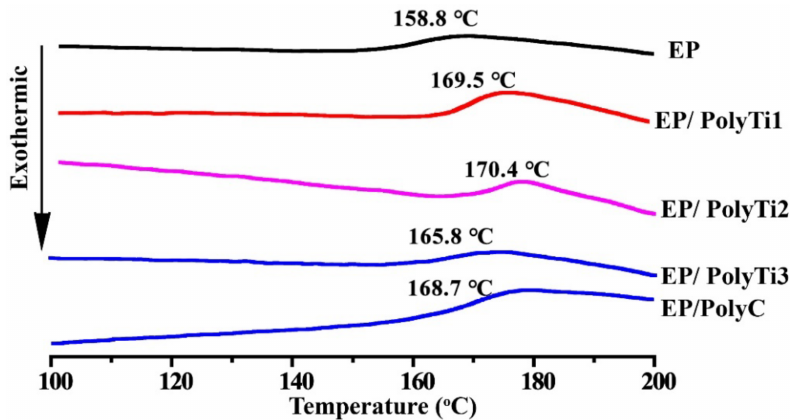
Figure 11. The DSC curves of EP/PolyTi and EP/PolyC